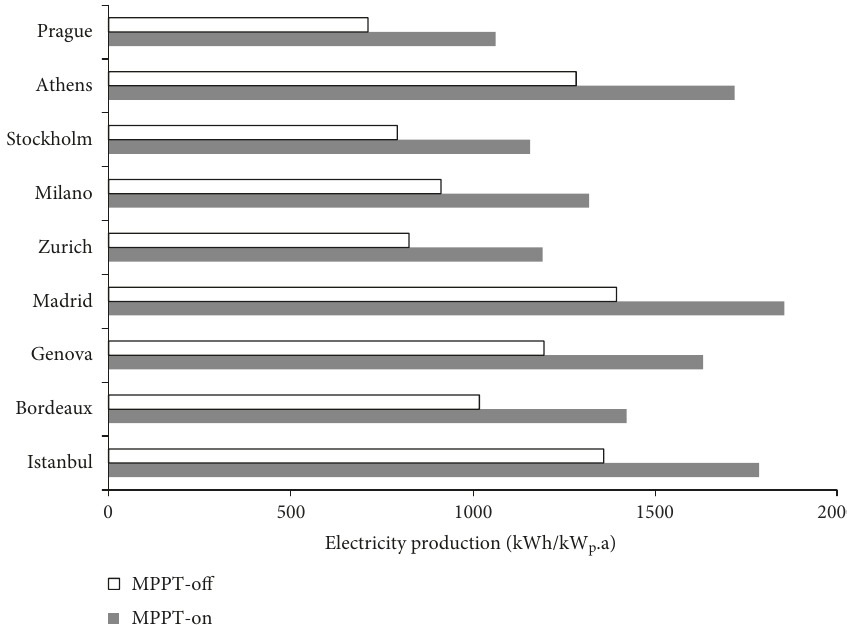
Figure 4: Speci fi c electricity yields of PV array in di ff erent climates for maximum power point tracking mode (MPPT-on) and for optimized load resistance mode (MPPT-o ff ).